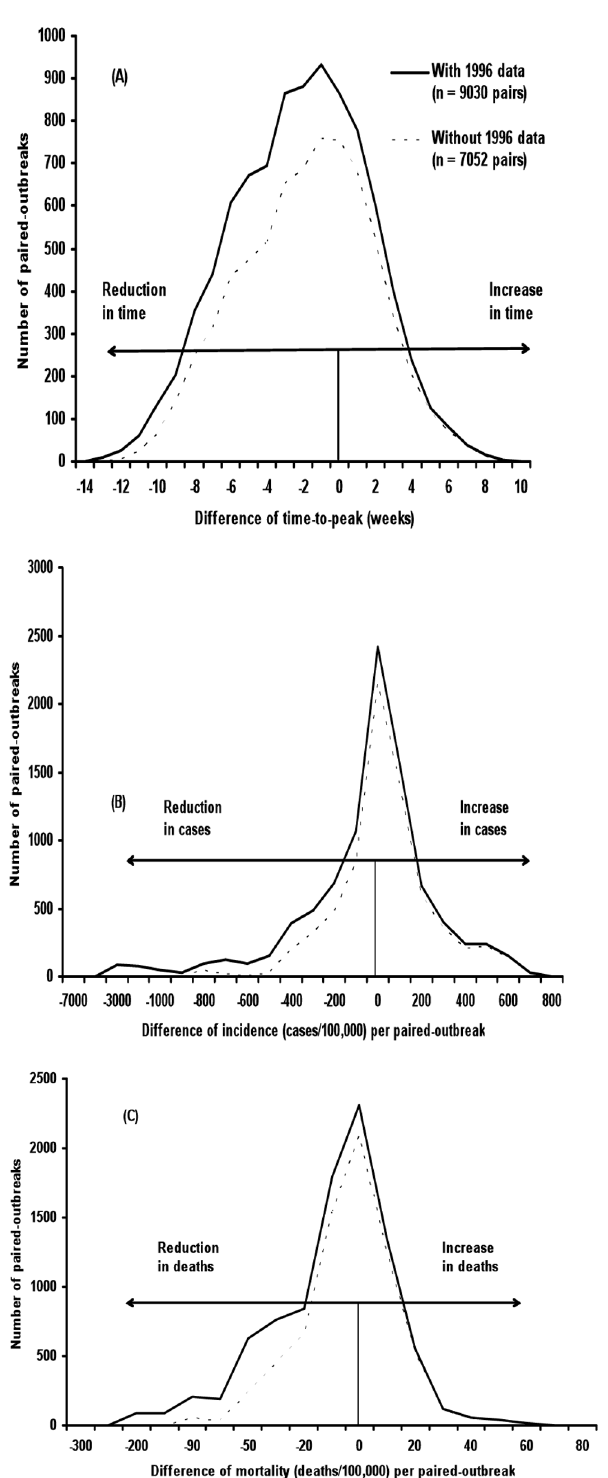
Figure 4. Sensitivity analysis: Distribution of paired compari- son of outbreaks before and after IDSR: Difference in time-to- peak, incidence rate, and mortality rate. Note: Comparison of data of each of the 105 outbreaks before IDSR with each of the 86 outbreaks after IDSR. Removing 1996 data reduces total outbreaks before IDSR to 82. Effects on outcomes correlated with IDSR are represented on the horizontal axes: negative numbers indicated reducing effects and positive numbers indicated increasing effects on time-to-peak of